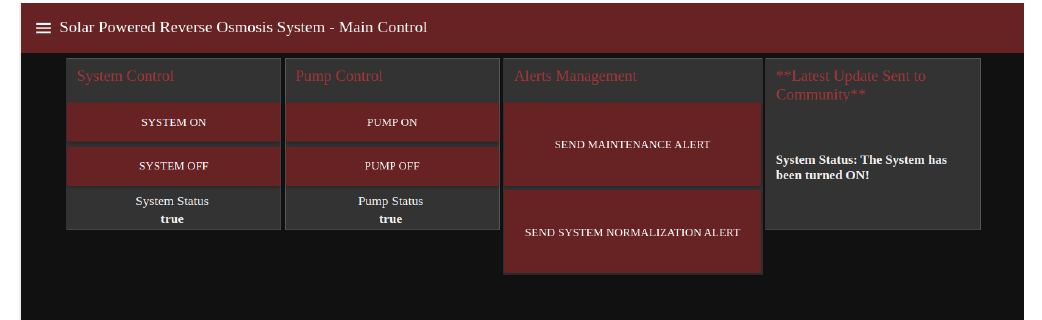
Figure 11. Node-Red Dashboard for operation. The Node-Red real-time monitoring dashboard was created to show the live values of several process parameters. Scaling of the analog return values was performed to read the actual pressure. Figure 12 shows the Node-Red real-time monitoring dashboard.